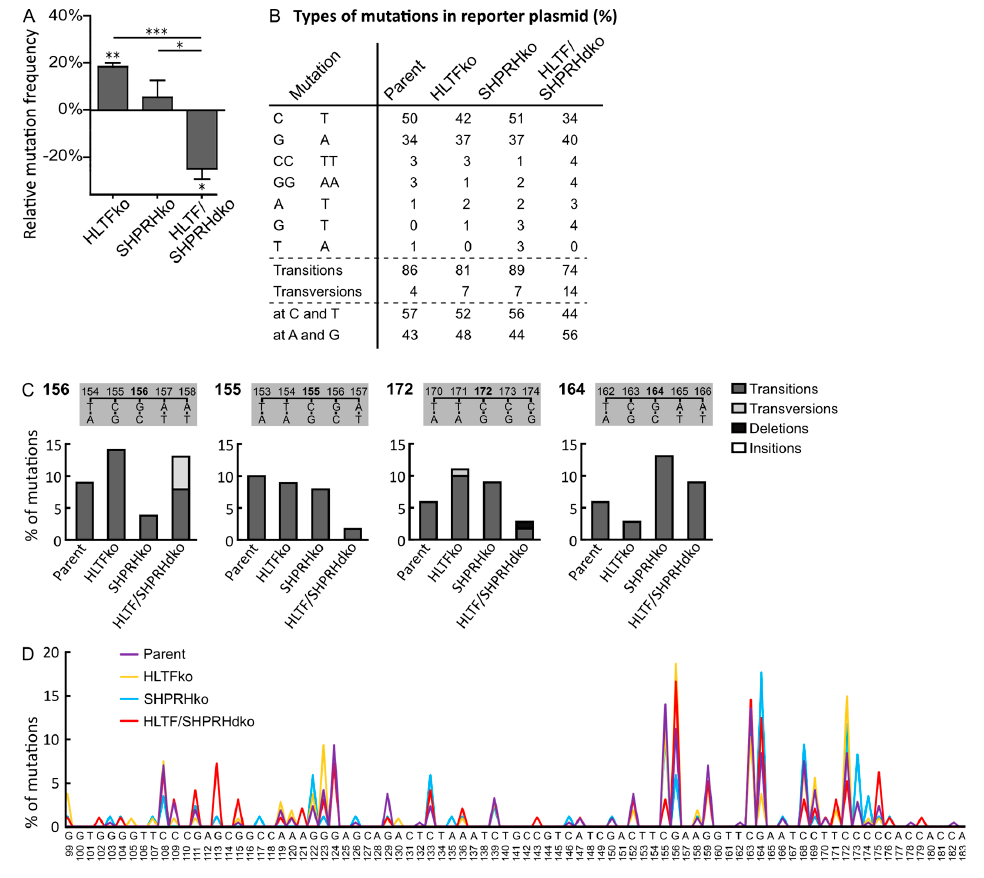
Figure 2. HLTF reduces error-prone DNA damage tolerance (DDT) after UVB-irradiation. ( A ) Mutation frequencies after overexpression of UVB damaged supF reporter plasmid pSP189 relative to control (Hap1 parent cell line) with a number of colonies counted for HLTF ko (n = 11,265), SHPRH ko (n = 25,059), HLTF / SHPRH dko (n = 13,325), Parent (n = 25,725), two-sided student’s t -test, * p < 0.05, ** p < 0.01, *** p < 0.001. ( B ) Quantification of types of mutations from sequencing mutant colonies from ( A ). Mutations with a prevalence ≥ 2% are depicted. Mutations found at T or C bases in supF are counted as mutations originated on the (sequenced) coding strand, mutations at A or G bases are considered to be C and T mutations originating from the transcribed strand. HLTF ko (n = 141), SHPRH ko (n = 112), HLTF / SHPRH dko (n = 127), Parent (n = 282). ( C ) Mutations at positions 155, 156, 164, 172 in supF gene from SupF UVB ( A ) in % with a prevalence of ≥ 10% in isolated plasmids from at least one cell line. ( D ) Mutation spectra of the supF gene received from sequencing mutant colonies from ( A ). HLTF ko (n = 141), SHPRH ko (n = 112), HLTF / SHPRH dko (n = 127), Parent (n =